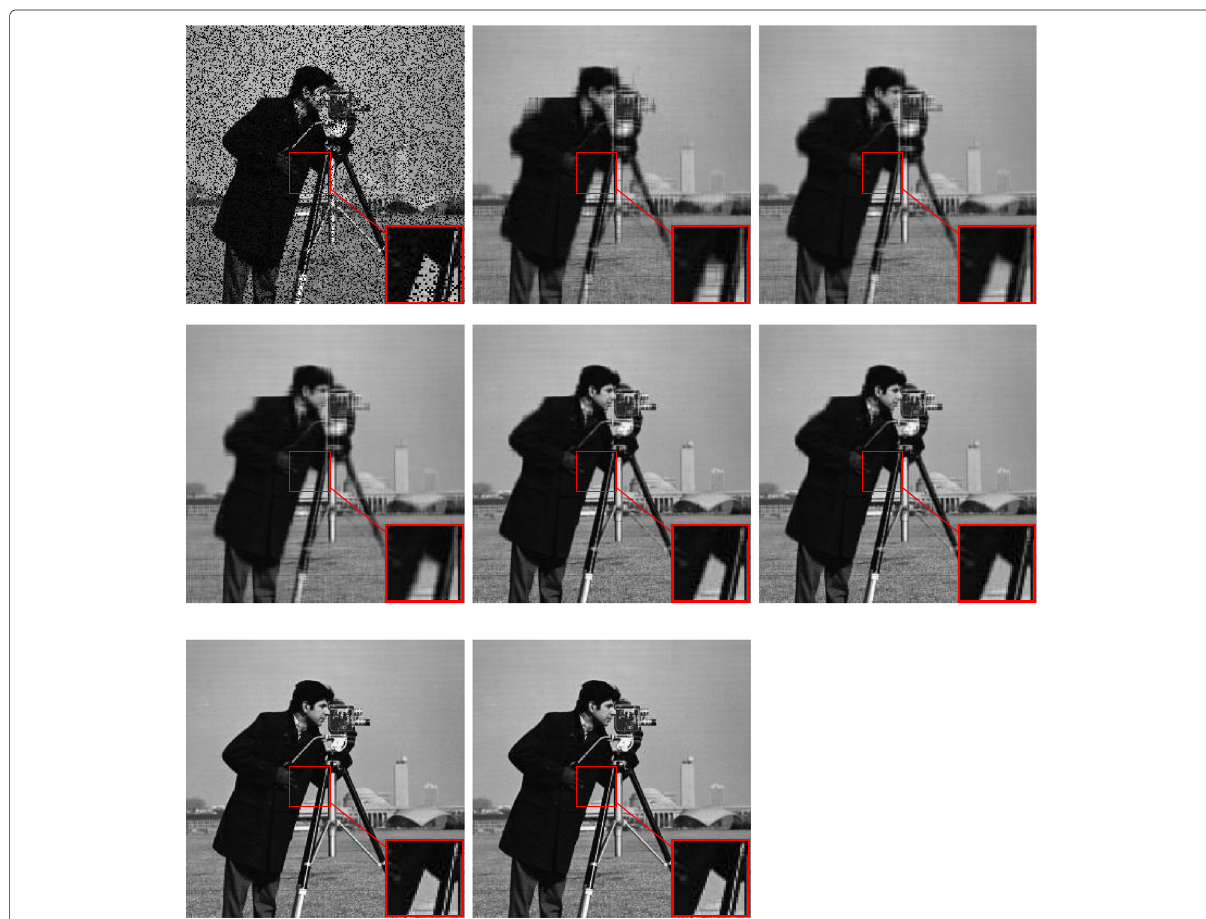
Fig. 3 Results obtained for image “cameraman” using the different methods. From left to right, the order of the images is as follows: simulated image with missing data, recovered image using FPC algorithm, recovered image using ALM algorithm, recovered image using IALM algorithm, recovered image using PPG algorithm, recovered image using PG algorithm, recovered image using SVT with power method, and finally the recovered image using our proposed